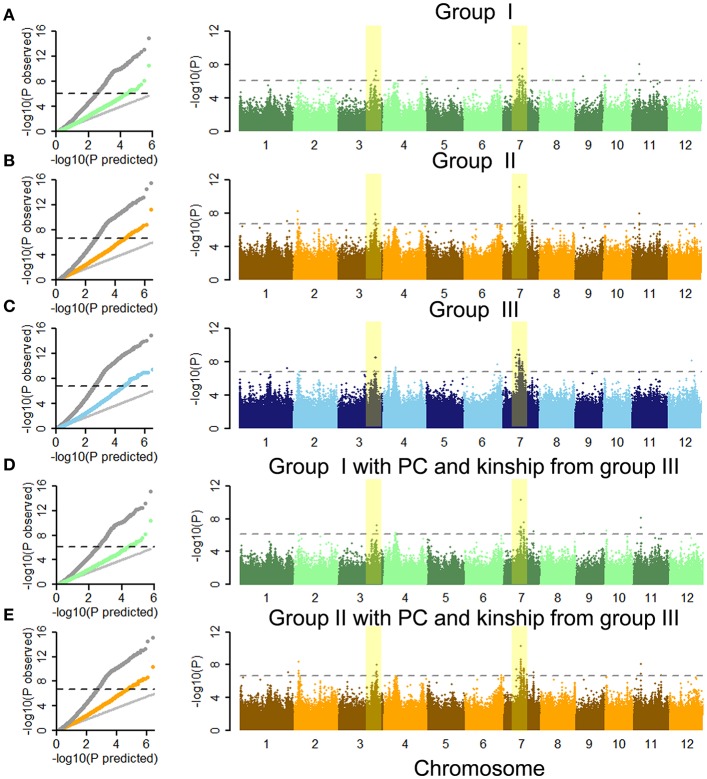
Genome-wide association studies of mesocotyl length under CMLM in full population using three sets of SNPs and different PC and kinship. Quantile-quantile plots and Manhattan plots of the CMLM using groups (A) I, (B) II, and (C) III in full population. Quantile-quantile plots and Manhattan plots of CMLM using groups (D) I and (E) II with PC and kinship derived from group III in full population. In quantile-quantile plots, gray dots show GLM, and other colored points show CMLM. The horizontal black dashed lines in Manhattan plots of CMLM show thresholds at p = 0.01 after Bonferroni-adjusted multiple test correction. Yellow stripes show two important signals in three GWAS using three sets of SNPs in the full population.